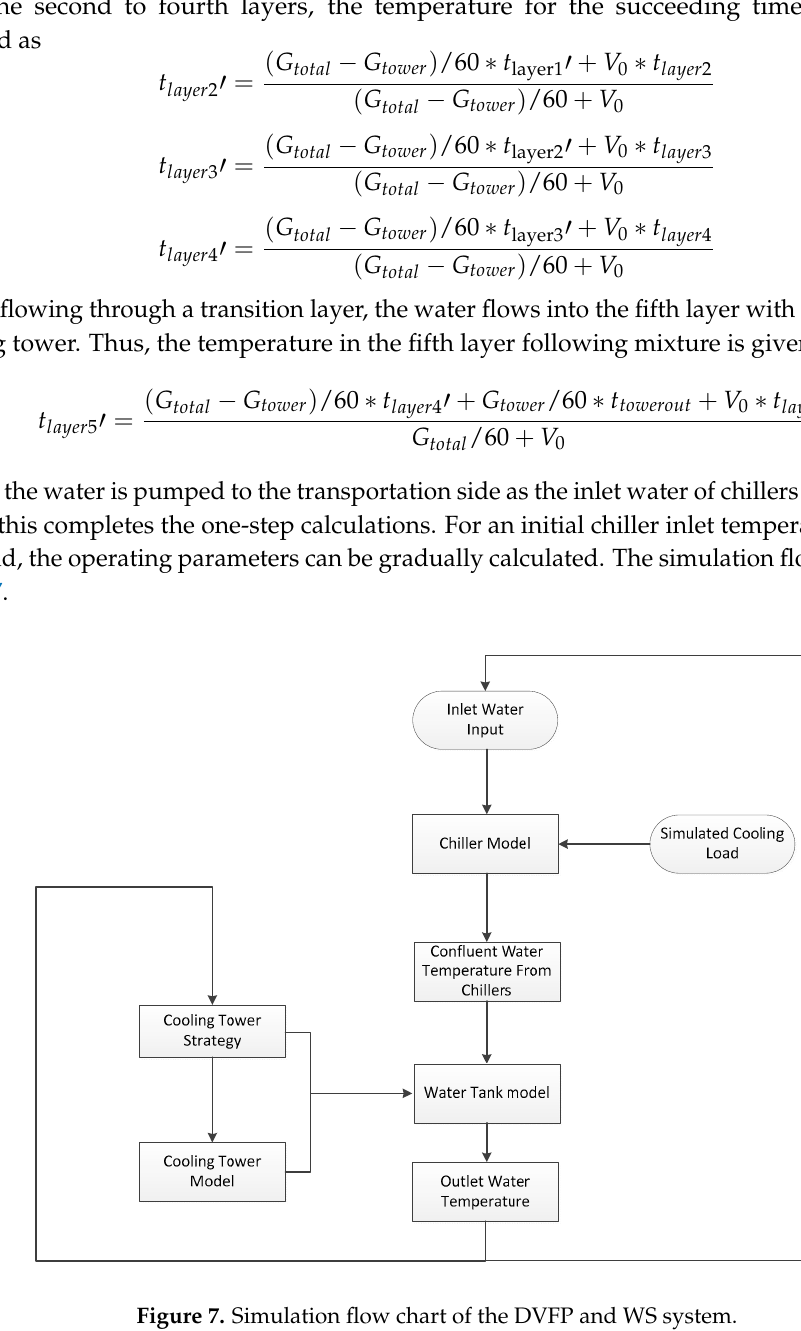
Figure 7. Simulation flow chart of the DVFP and WS system.